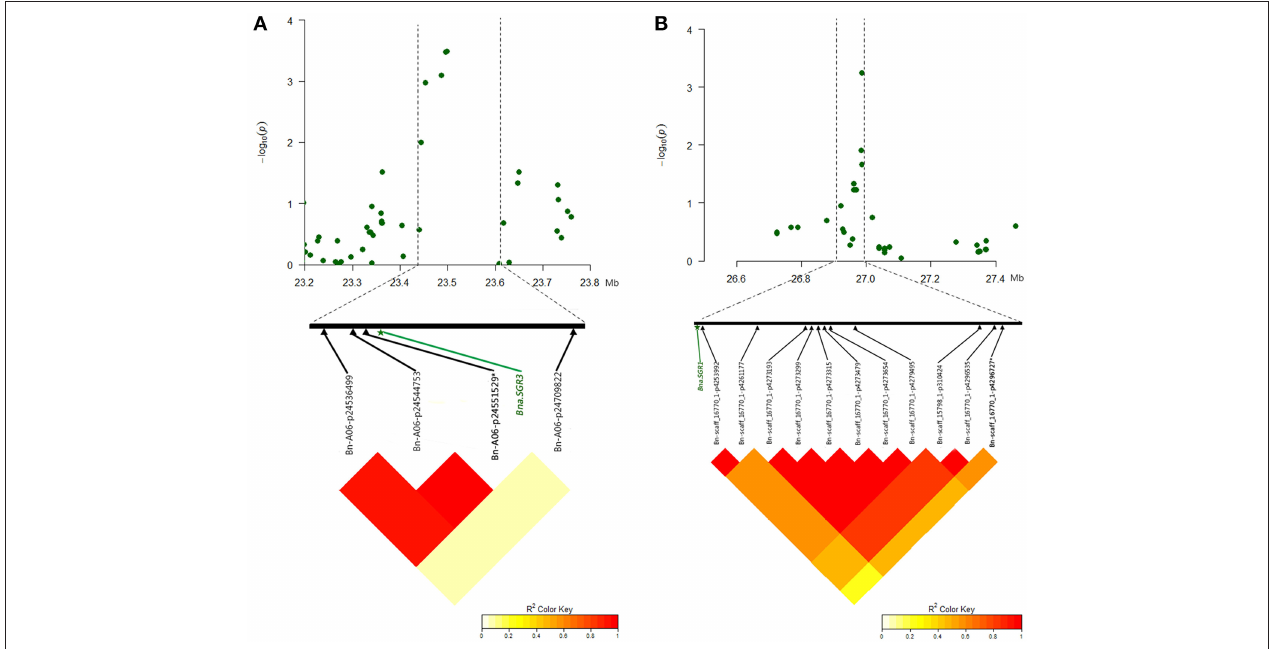
FIGURE 6 | Significantly associated SNPs and corresponding candidate genes identified for branch angle in MLM. (A) Manhattan plot of the A6 chromosomal region around the candidate BnaA06g35880D ( Bna.SGR3 ) in E2 and LD plot with a peak SNP Bn-A06-p24551529 and both flanking SNPs. (B) Manhattan plot of C8 chromosomal region around candidate BnaC08g25070D ( Bna.SGR1 ) in E1 and LD plot with a peak SNP Bn-scaff_16770_1-p4296727 and both flanking SNPs. The SNP written in bold and marked with an asterisk indicates the peak